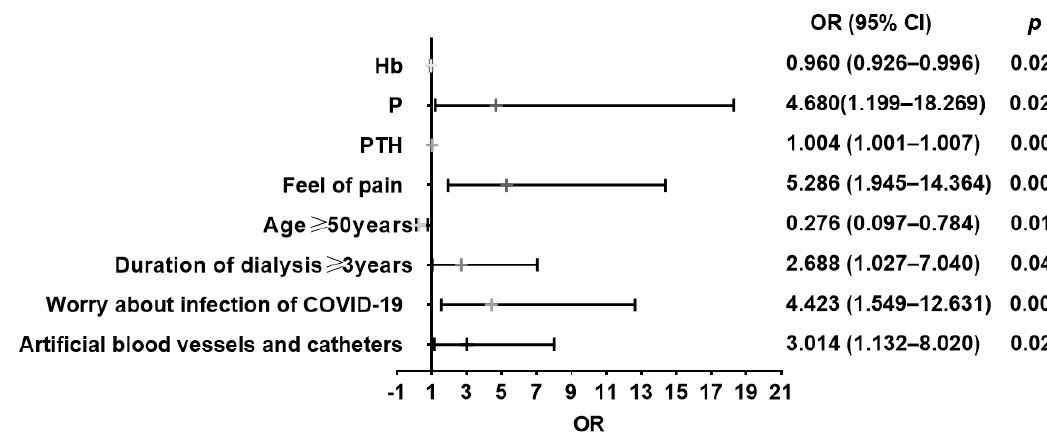
Figure 6. Logistic analysis of risk factors of depression in the MHD patients.